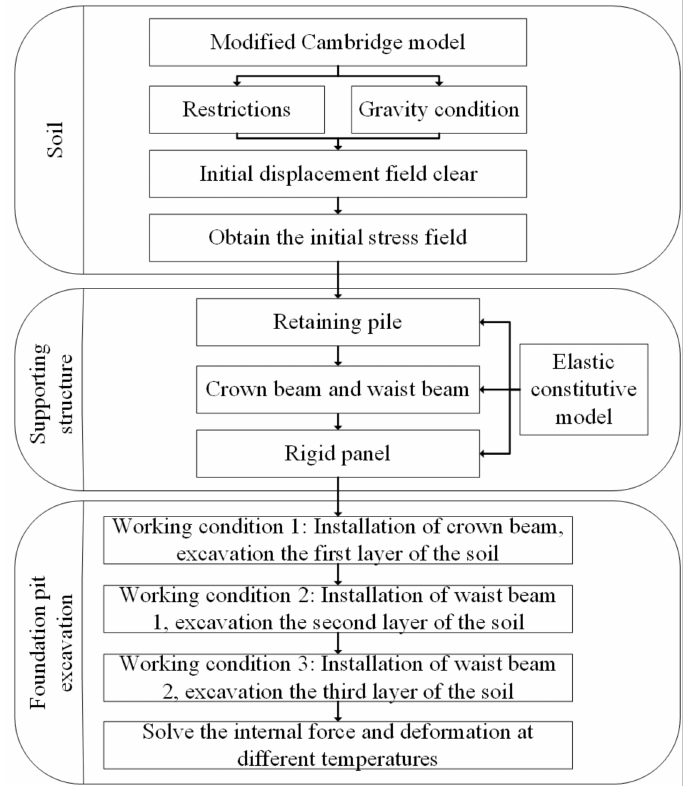
Figure 19. The flow chart of the modeling and